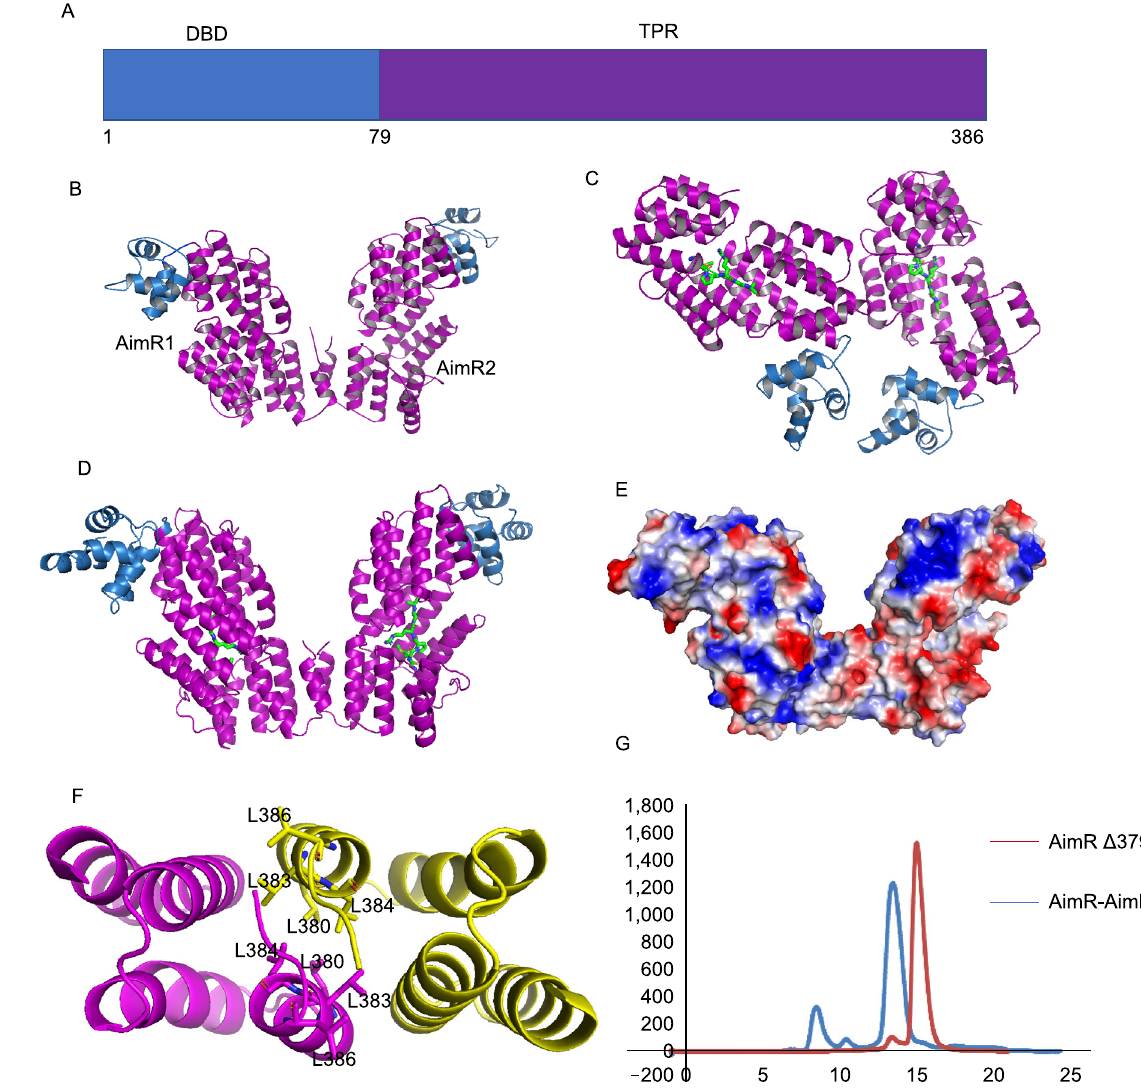
Figure 1. Overall structures of apo AimR and AimR-AimP complex . (A) Domain organization of AimR. (B) Structure of apo